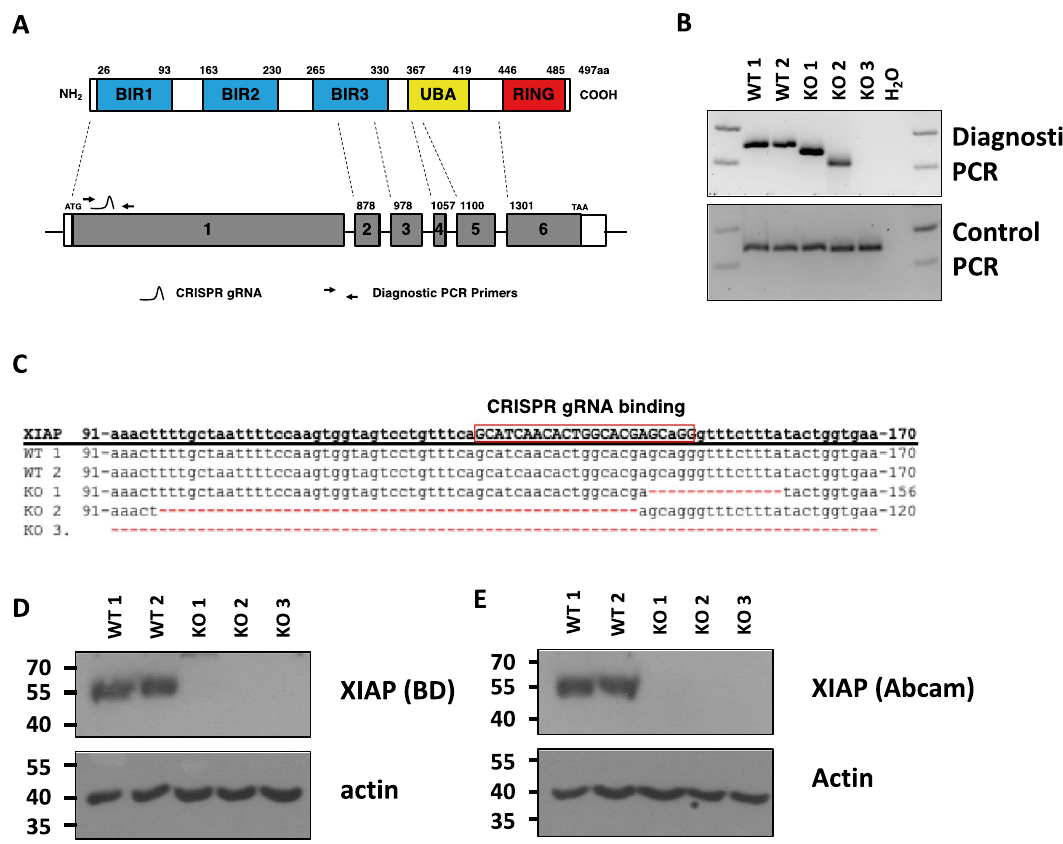
Figure 1. Creation of XIAP null cell lines. ( A ) Schematic of the exon structure of the XIAP gene and the domains of the XIAP protein. Location of the CRISPR gRNA binding site and the diagnostic PCR primers are indicated. ( B ) PCR analysis of genomic DNA prepared from U2OS clonal cell lines prepared from CRISPR/Cas9 transfected cells. ( C ) Alignment of the sequencing data of XIAP exon 1 from clonal cells lines. Whole cell